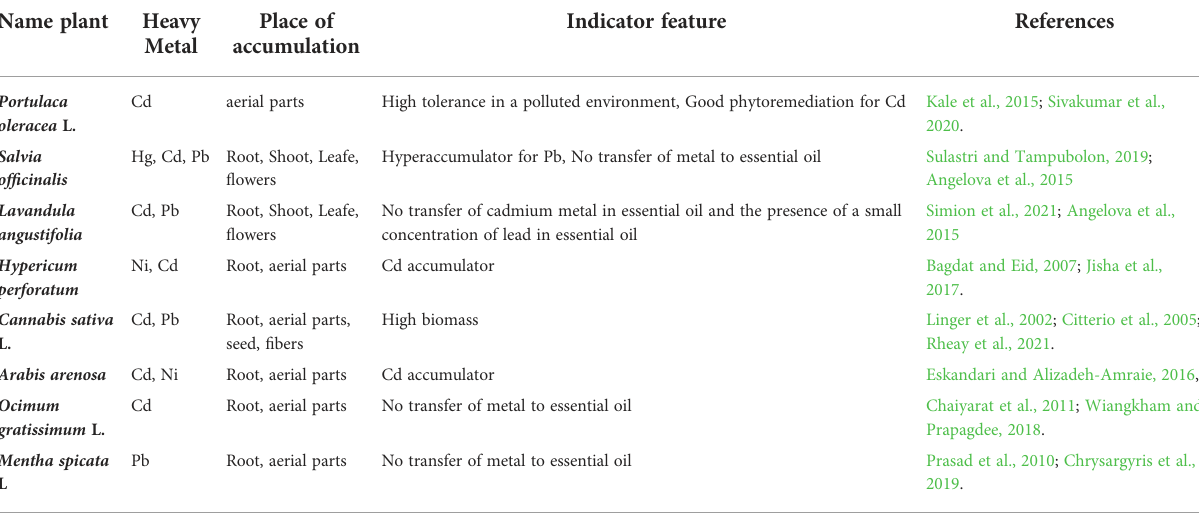
TABLE 2 Some medicinal plants evolved with an extensive and ef fi cient mechanism to adapt to heavy metal stress. Name